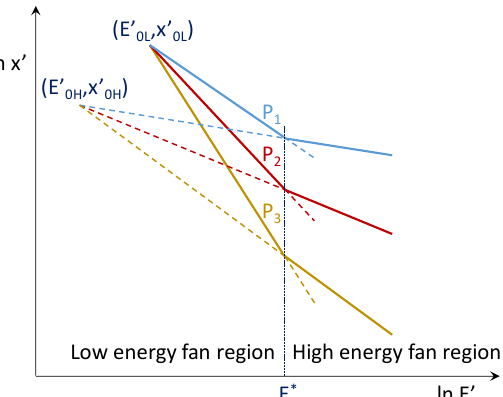
( E (cid:48) ) fan lines at E ∗ . P 1 , P 2 , P 3 are P